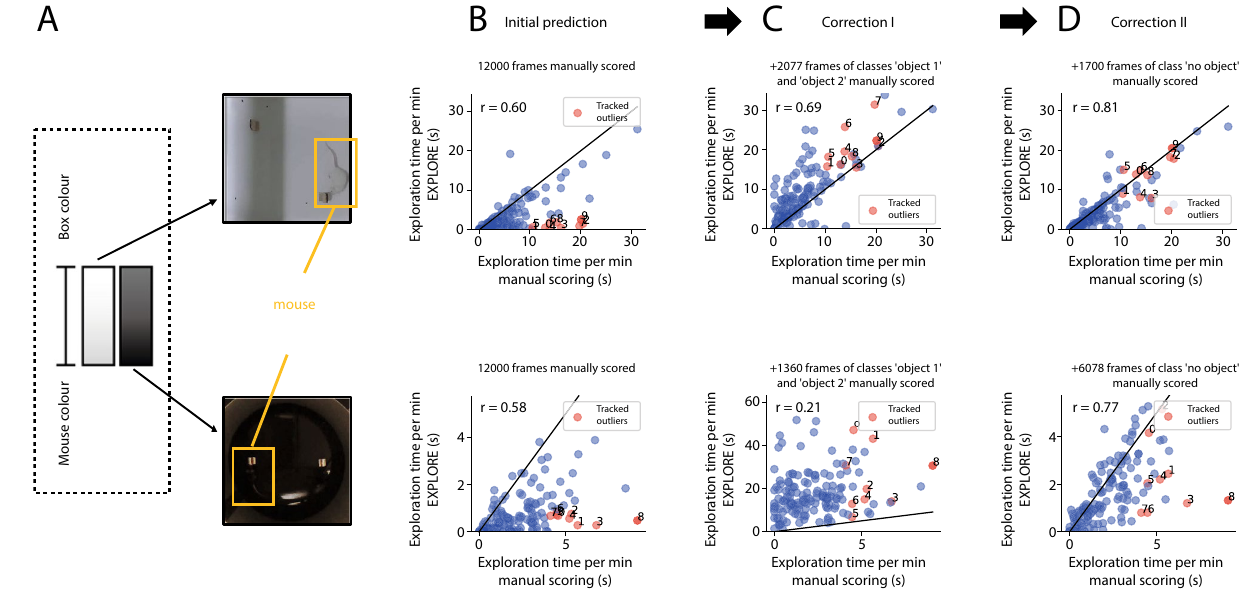
Figure 2. EXPLORE is able to perform well even under difficult light conditions. ( A ) Results are shown for a standard experiment with 2 objects in a white quadrangular arena with white mice and in a black round arena with black mice. ( B ) Scatterplots indicating the performance of EXPLORE for the initial prediction with 12000 labeled frames for training and its correlation to the human rater for each of the light settings. Outliers are labeled in red and numbered to track them during correction steps. ( C ) Scatterplots of the prediction after adding training data with frames specifically labeling the objects of the arena (“object 1” and “object 2”). ( D ) Scatterplots revealing the prediction performance of EXPLORE after adding another training data set without any object (“no object”) and its correlation to the rater after re-prediction. In particular the correlation of outliers (in red) strongly improved compared to